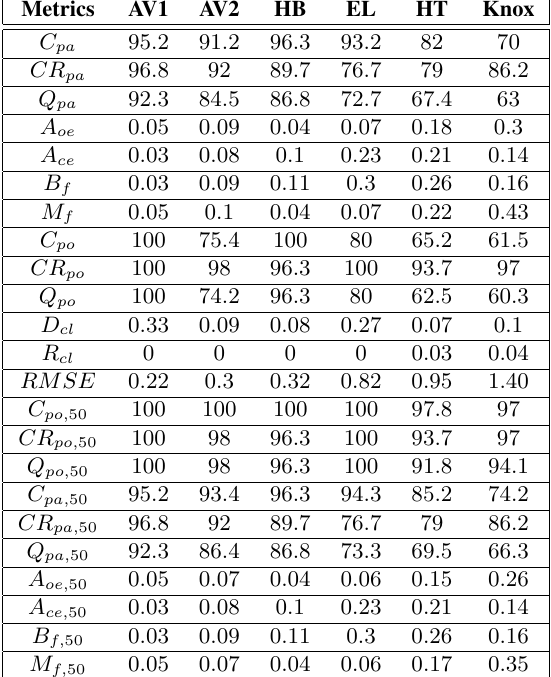
Table 2: Building detection results. Pixel-based: completeness ( C pa ), correctness ( CR pa ), quality ( Q pa ), area omission error ( A oe ), area commission error ( A ce ), branching factor ( B ), and f miss factor ( M ) for buildings and buildings over 50 m 2 . Object- Table 3: Roof plane extraction results. Pixel-based: complete- f based: completeness ( C po ), correctness ( CR po ), quality ( Q po ), ness ( C pa ), correctness ( CR pa ), quality ( Q pa ), area omission er- detection cross lap ( D ), and reference cross lap ( R ) for build- ror ( A oe ), area commission error ( A ce ), branching factor ( B ), cl cl f ings and buildings over 50 m 2 . Geometric: roof mean square and miss factor ( M ) for roof planes and roof planes over 10 m 2 . f error (RMSE). Object-based: completeness ( C po ), correctness ( CR po ), quality ( Q po ), detection cross lap ( D ), and reference cross lap ( R ) cl cl